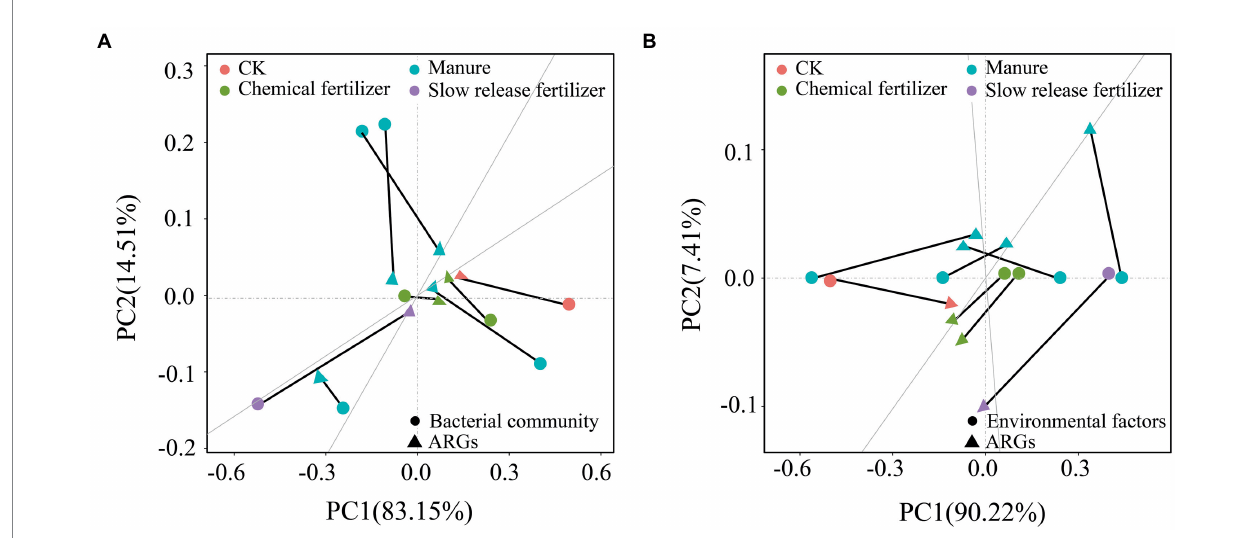
FIGURE 5 Procrustes analysis (PC) showing the correlation between microbial community (A) and environmental factors (B) with changes in ARGs in paddy soils under different fertilization